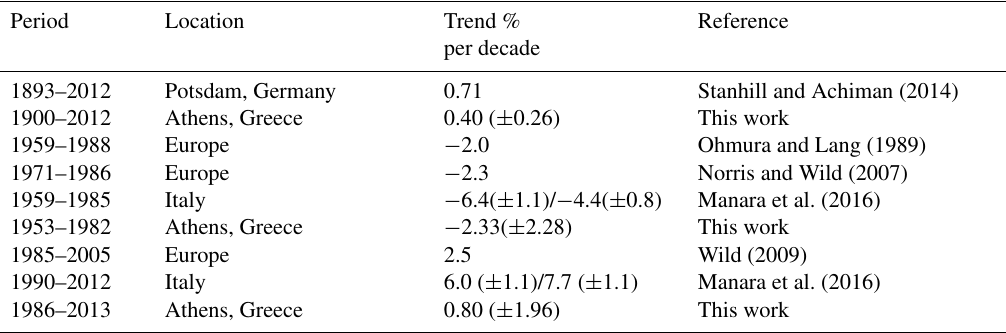
Table 5. Summary of percent SSR changes per decade for various locations.